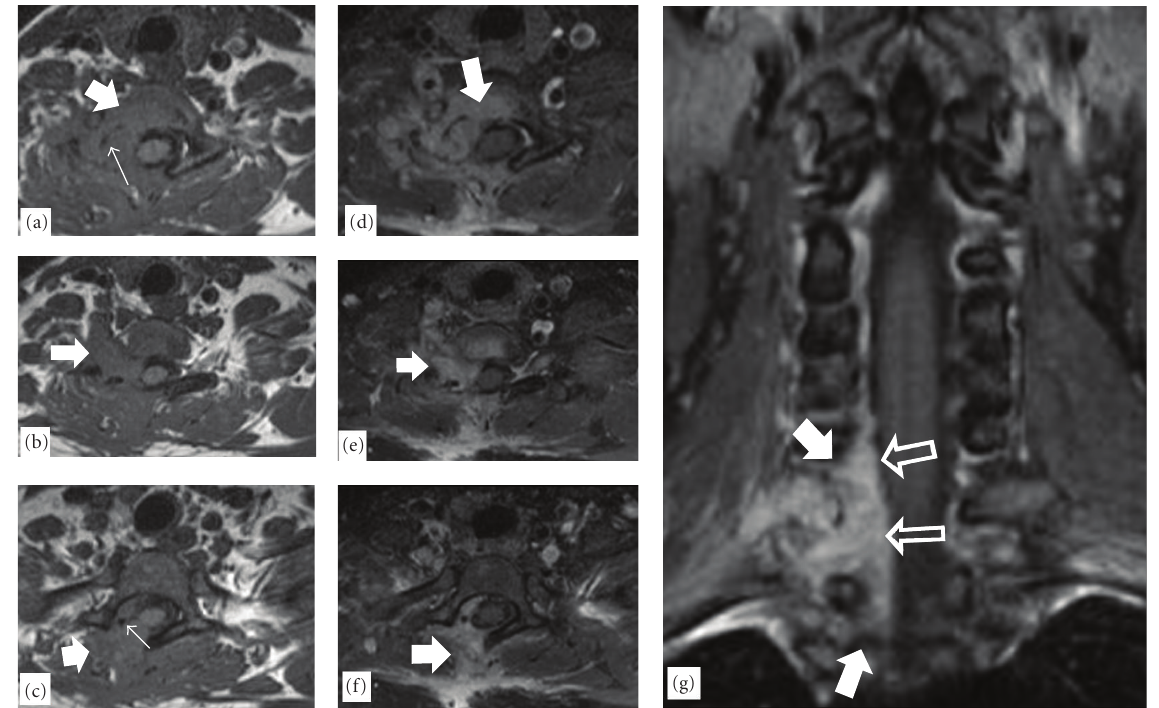
Figure 5: A 41-year-old female with a recurrent chondrosarcoma of the lower cervical spine. The axial T1-w MR images ((a)–(c)), show a soft-tissue mass in the right lower cervical spine (arrows) with foci of calcifications (thin arrows). The fat-suppressed contrast-enhanced MR images ((d)–(f)) show the intense enhancement of the lesion (arrows). (g) The coronal fat-suppressed contrast-enhanced MR image, shows the extension of the lesion within the right epidural space (arrows), with spinal cord displacement (open arrows).